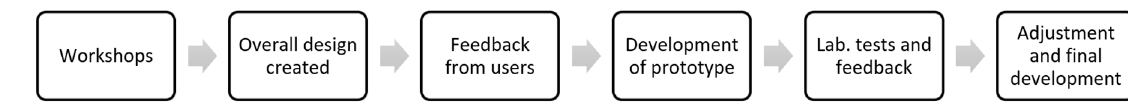
Figure 3. The user activities and the design and development activities in phase 2.